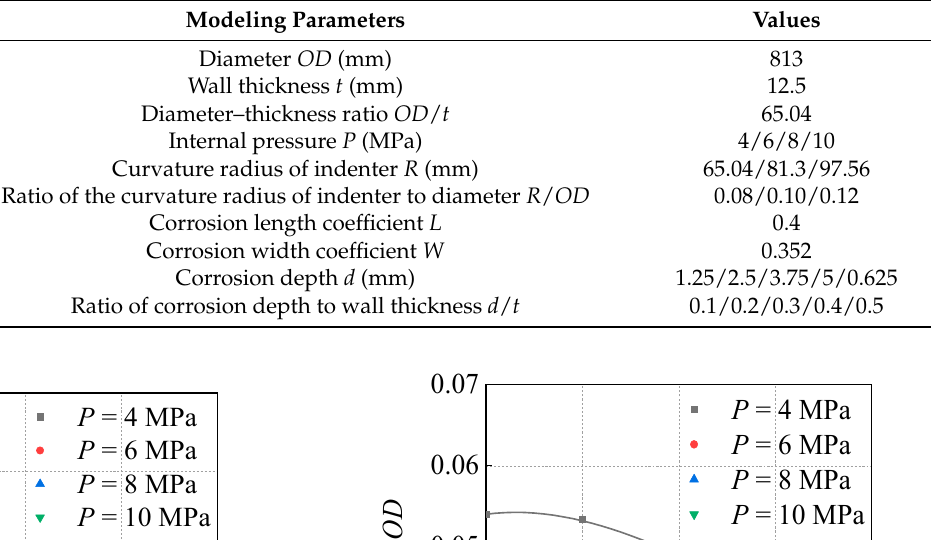
Table 4. Model parameters for analysis of the influence of geometrical parameters on dent depth under different conditions.